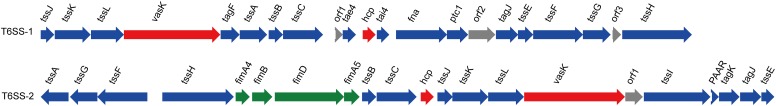
Schematic representation of the two T6SSs gene loci in Cronobacter sakazakii. Core components of the T6SSs are shown in blue. Uncharacterized genes are shown in gray. In the T6SS-2 cluster, fimA4, fimB, fimD, and fimA5 are pilus-associated genes. The mutant genes in the experiment are shown in red.